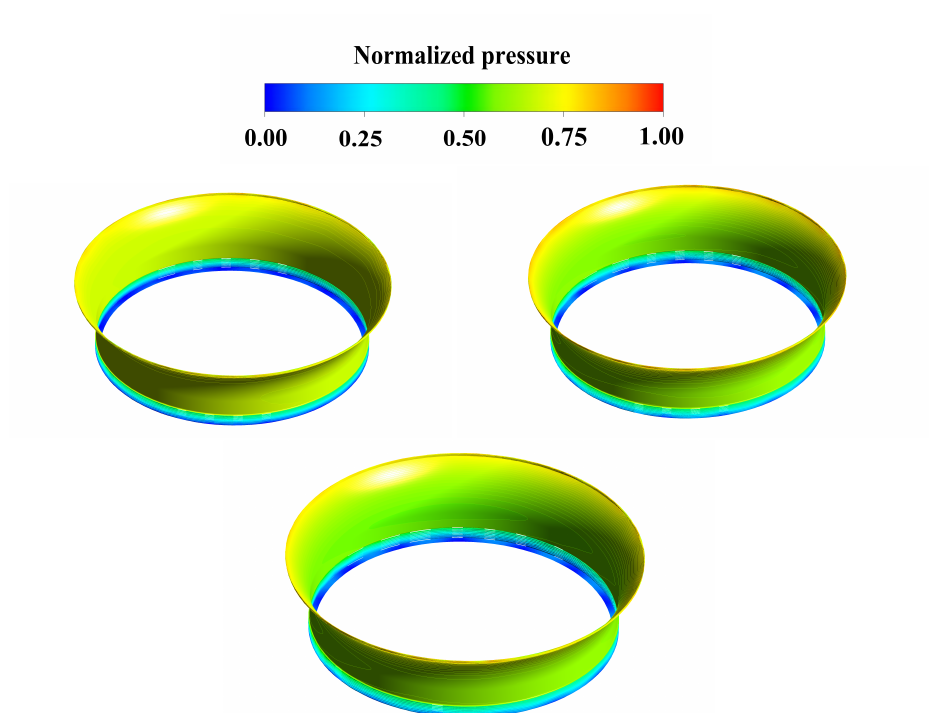
Figure 9. Pressure distributions of the bottom ring with the 0.5 mm ( top-left ), 1.5mm ( top-right ), and 2.5 mm ( lower ) radial installation deviation models with speed.